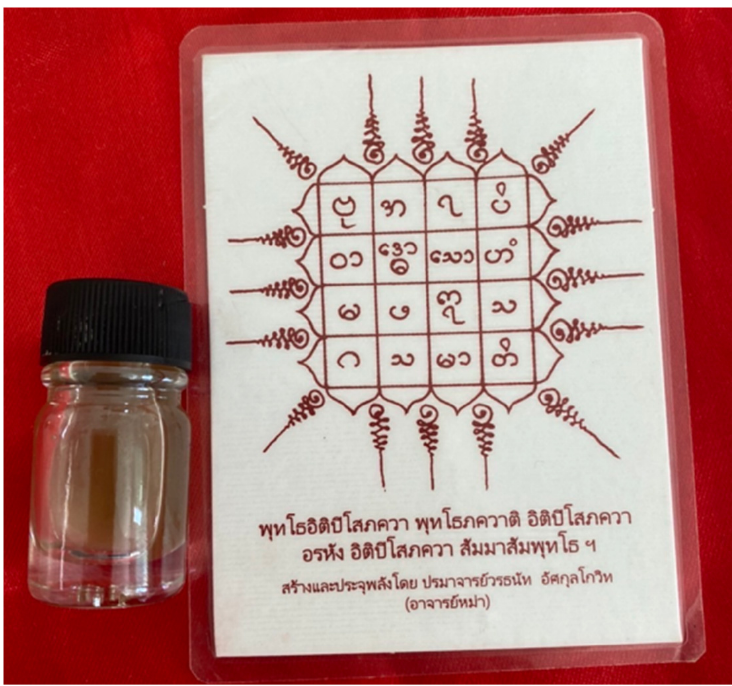
Figure 1. Magic items; enchanting oil ( left ) and paper yantra ( right ).